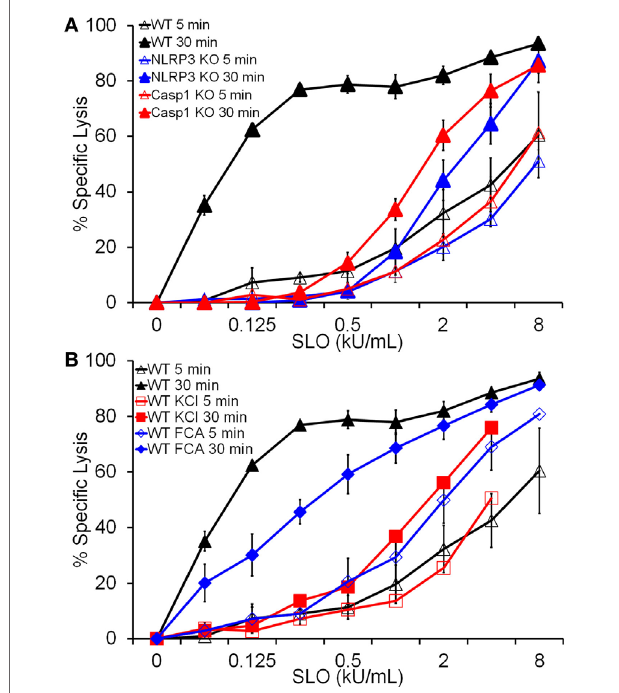
FigUre 5 | Dnase1l3 inhibition mildly impairs pyroptosis . Lipopolysaccharide-primed BMDM of the indicated genotypes were treated with the indicated inhibitors and streptolysin O (SLO) at the listed concentrations for 5 or 30 min in the presence of propidium iodide and analyzed via FACS. The same data for wild-type BMDM samples were used for both panels (a,B) . Graphs are mean ± SEM of at least three independent